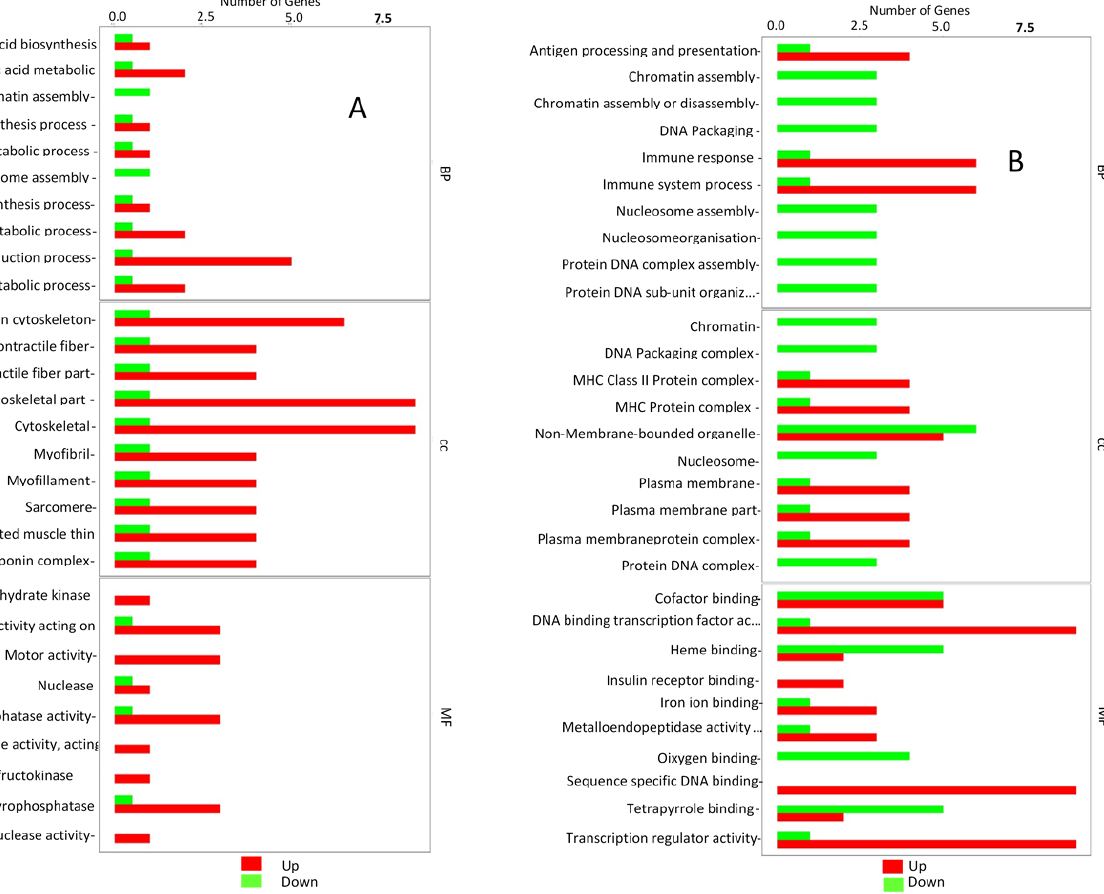
Figure 6. Gene Ontology analysis bar plots for the most significantly enriched pathways under chronic stress. ( A ) Ammonia treatment showing the 10 most significantly enriched pathways in the Cellular component, Biological Process and molecular Function categories. The green bars represent the down-regulated genes while the red bars represent the up-regulated genes. ( B ) Stocking density treatment showing the 10 most significantly enriched pathways in the Cellular component, Biological Process and molecular Function categories. The green bars represent the down-regulated genes while the red bars represent the up-regulated genes. The proportion of the red (up-regulated) to the Green (down-regulated) depicts the level of pathway enrichment.